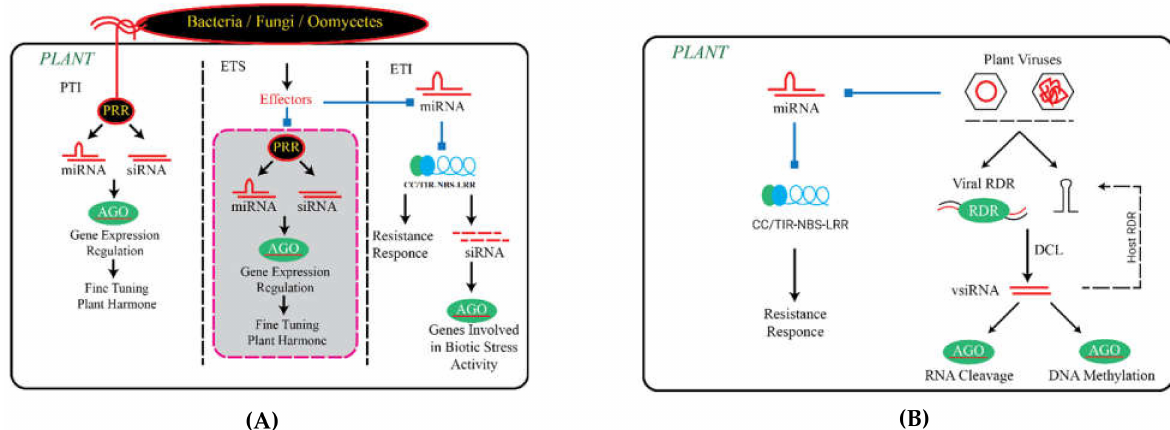
Figure 4. The role of sRNAs in plant immunity. ( A ) The role of small RNAs (sRNAs) during the interaction between plant and pathogens. ( B ) Plants defend against virus attacks by silencing the viral DNA/RNA genome through RNAi. Both microRNAs (miRNAs) and virus-derived small interfering RNAs (vsiRNAs) are involved. CC, coiled-coil; PTI, pathogen-associated molecular pattern-triggered immunity; ETS, effector-triggered susceptibility; ETI, effector-triggered immunity; PRR, pattern recognition receptor; DCL, dicer-like protein; HEN 1, HUA ENHANCER 1; LRR, leucine-rich repeat; NBS, nucleotide-binding site; RDR, RNA-dependent RNA polymerase. CC, coiled-coil; TIR, transport inhibitor response; LRR, leucine-rich repeat; RDR, RNA-dependent RNA